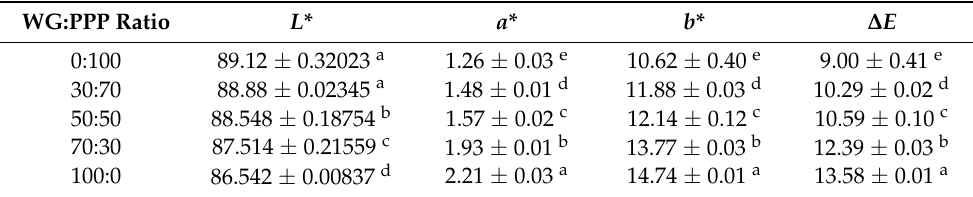
Table 6. Color of raw materials with different mixing ratios.